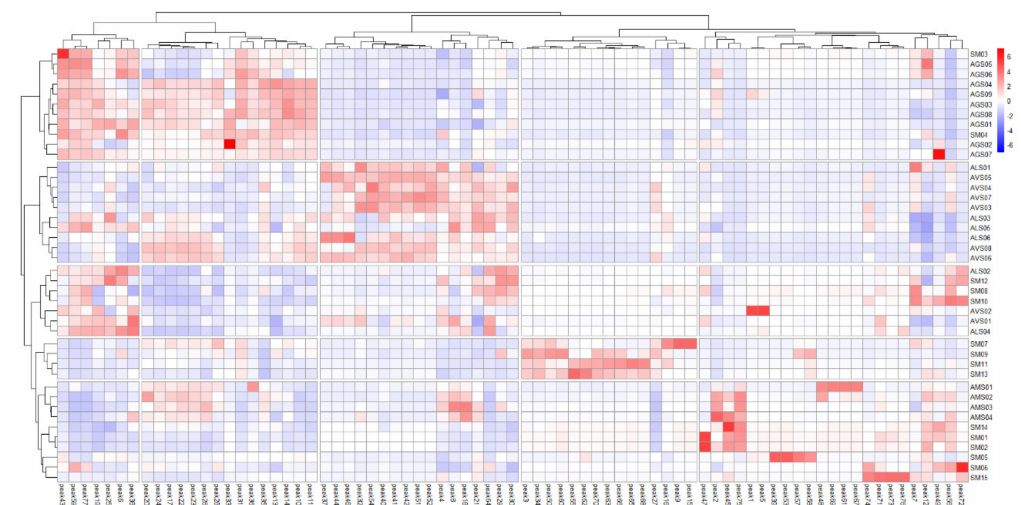
Figure 5. Clustered heatmap of Amomi Fructus samples and profiling peaks.